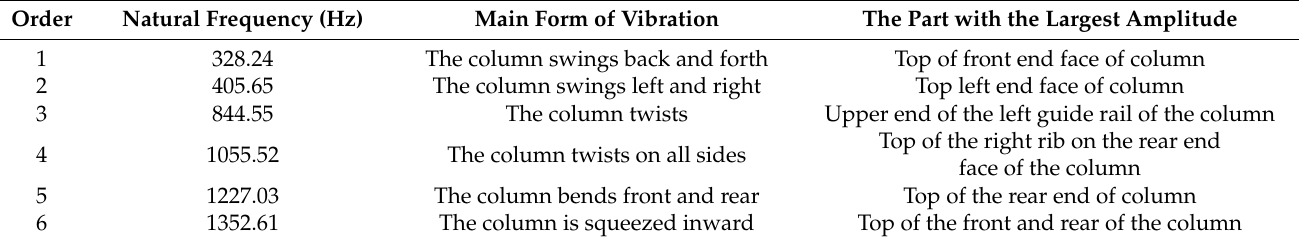
Table 3. Modal characteristics of integral structures.